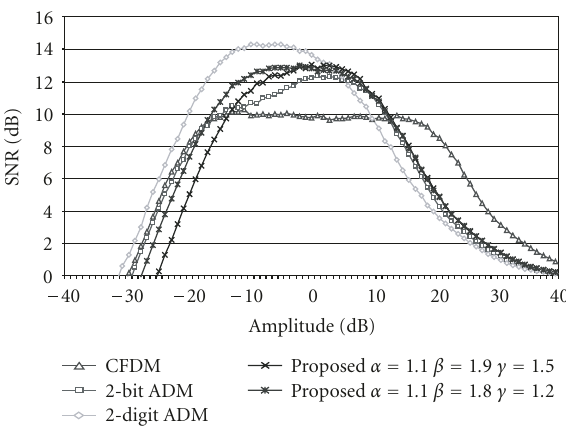
Figure 5: SNR values for di ff erent amplitudes of a speech input signal for the same output bit rate (dynamic range of step size: ±